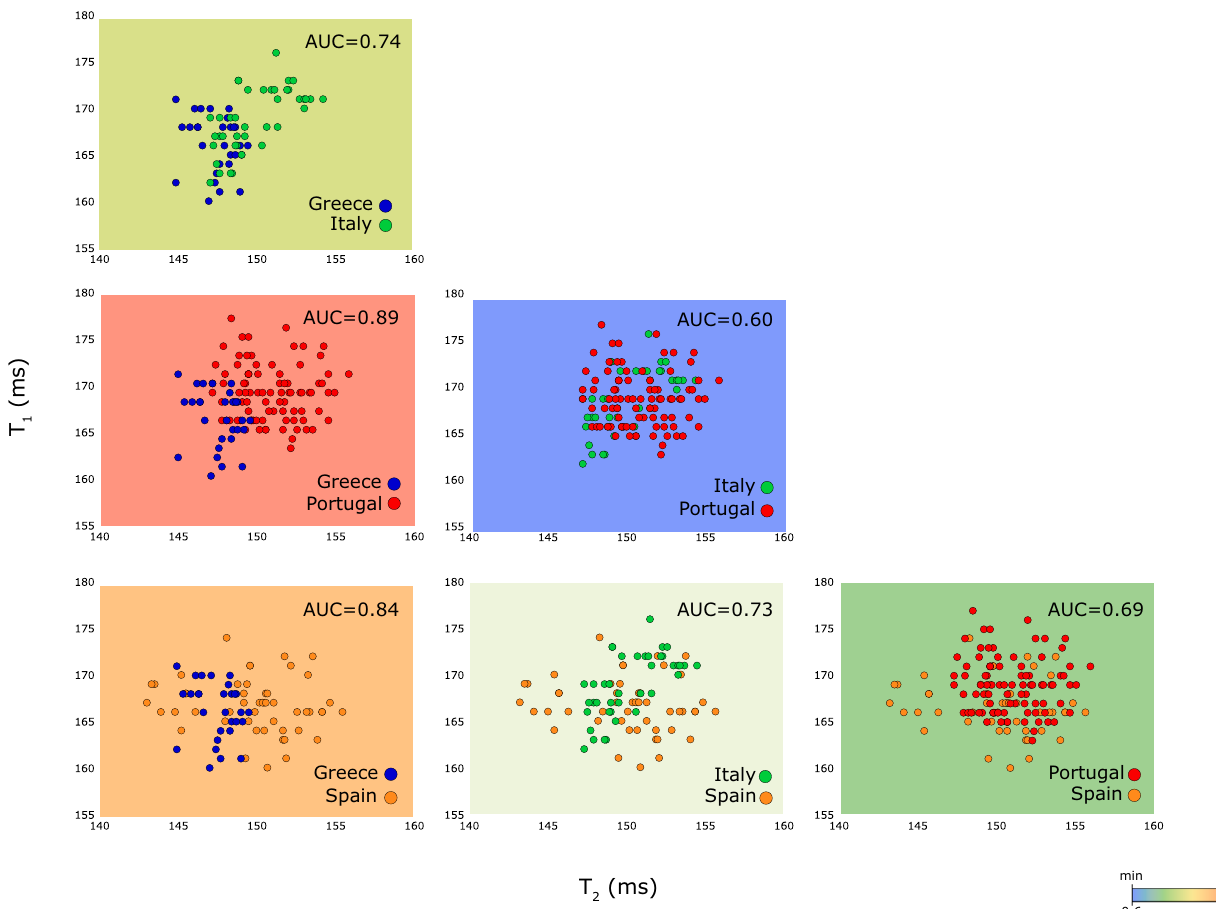
Fig. 3 Identi fi cation of the regions of origin of OO. EVOO samples were studied based on their regions of origin. Off-the-shelf EVOO samples originated from different European regions (i.e. 9 Portugal, 5 Spain, 4 Italy, 3 Greece) according to their labelling. Pair-wise two-dimensional mapping of EVOOs origin in the T 1 -T 2 magnetic state diagram, according to unpaired two-tailed Student t -tests (details in Supplementary Fig. 3). The sensitivity and speci fi city of each region were calculated using receiver operating characteristic (ROC). The substantially high AUC, ranging from 0.6 to 0.9 of each pair/wise region were